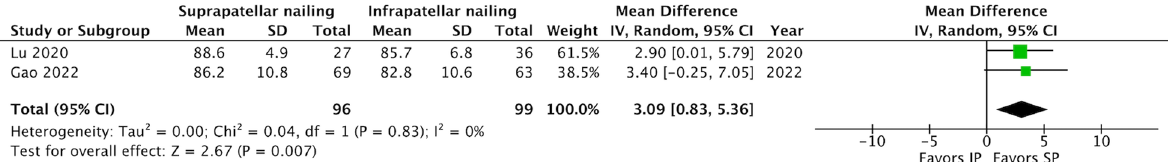
Fig. 3 Forest plot of knee function by Lysholm score 12 months after surgery. The SP group had a higher Lysholm score than the IP group (MD: 3.90 points; 95% CI 0.83 to 5.36; P 0.007; I 2 0%). MD median difference, CI confidence = =